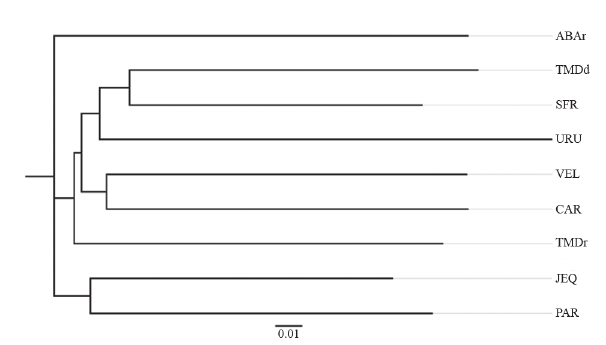
Fig. 2. Dendrogram representing the chord genetic distance among sampling groups of Prochilodus argenteus . ABAr = rio Abaeté at rainy season; CAR = rio Carinhanha lagoons; JEQ = rio Jequitaí lagoons; PAR = rio Paracatu lagoons; SFR = rio São Francisco lagoons; URU = rio Urucuia lagoons; VEL = rio das Velhas lagoons; TMDd = Três Marias Dam